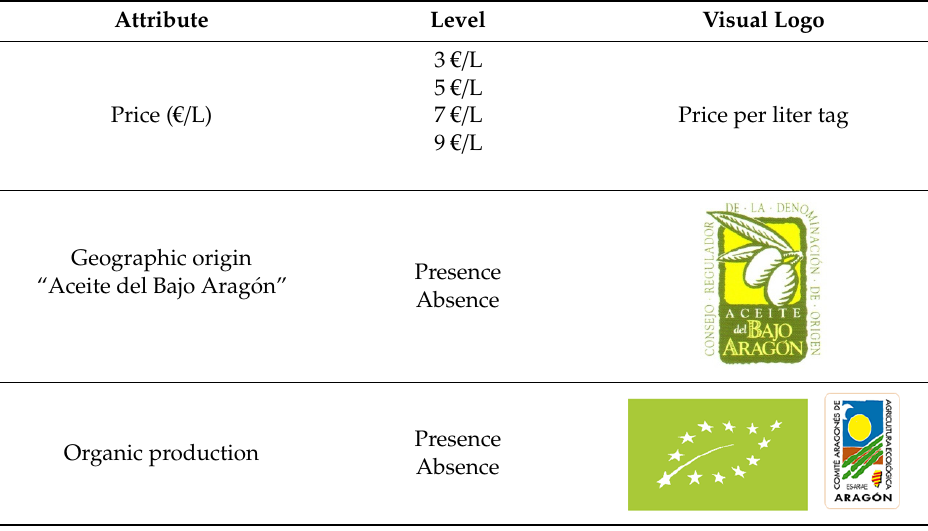
Table 1. Extra virgin olive oil attributes and levels.